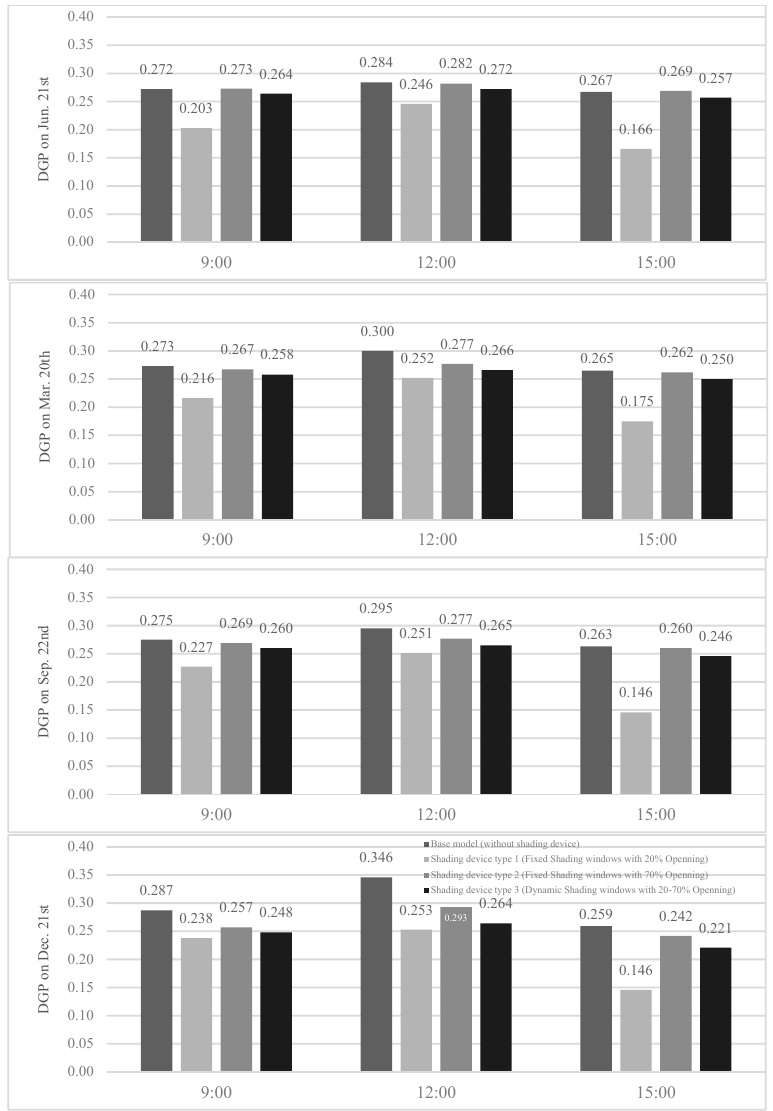
Figure 16. Daylight Glare Probability (DGP) analysis.